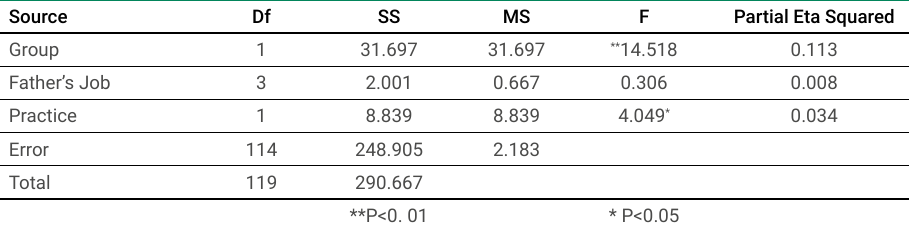
Table 6. Analysis of Covariance for the Effect of education on Practice Source Df